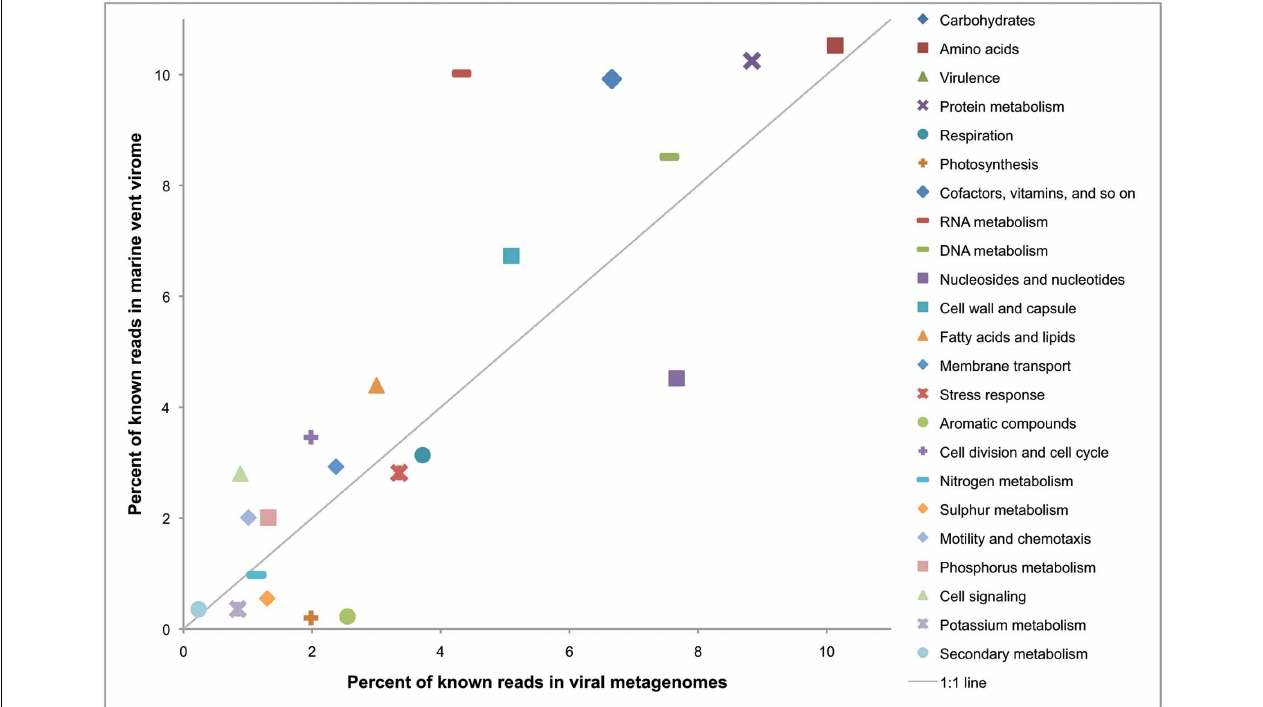
FIGURE 5 | Relative percentages of reads matching gene categories in the marine vent virome and a set of 42 viral metagenomes isolated from other environments (listed in Dinsdale et al., 2008). The solid line indicates